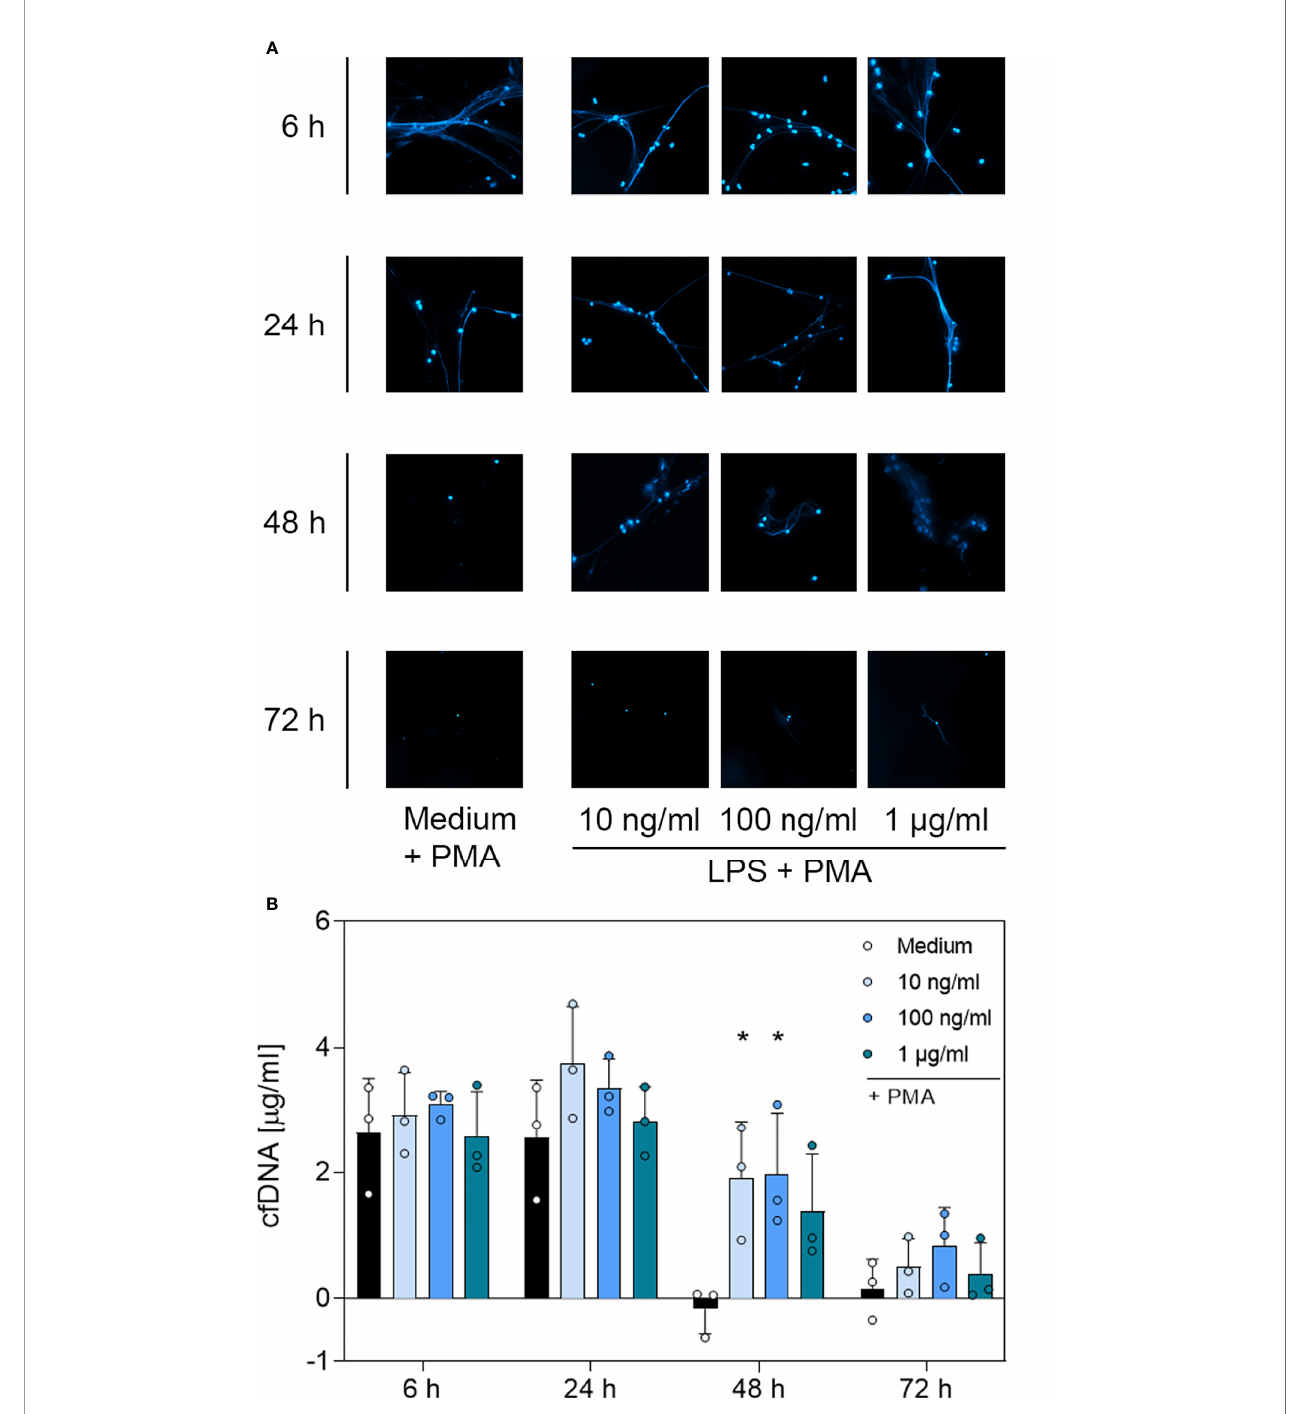
FIGURE 5 | Immuno fl uorescence imaging of extracellular DNA and quantitative analysis of PMA-induced cfDNA after incubation with LPS. (A) Immuno fl uorescence imaging shows extracellular DNA of neutrophils cultured with 10 ng/mL, 100 ng/mL, 1 µg/mL of LPS or of an untreated control (medium). Cells were stimulated with 20 nM PMA at the indicated time points. After fi xation, DNA was stained with 1 µg/mL DAPI (blue). PMA-induced NET formations can be detected after up to 48 h after treatment with LPS. Images represent areas with comparable cell density 40× magni fi cation. (B) Quanti fi cation of PMA-induced cfDNA release by fl uorometric measurement of cfDNA after treatment of neutrophil granulocytes with 10 ng/mL, 100 ng/mL or 1 µg/mL LPS compared to an untreated control (medium). Fluorometric measurement was conducted with samples stimulated with 20 nM PMA after 6 h, 24 h, 48 h and 72 h. LPS preserves cfDNA release for up to 48 h with signi fi cant differences compared to the untreated group at 48 h. Values represent means ± SD of n = 3. Differences between the untreated control group and one treated group each were calculated individually by student ’ s t-test. Levels of signi fi cance were set at < 0.05